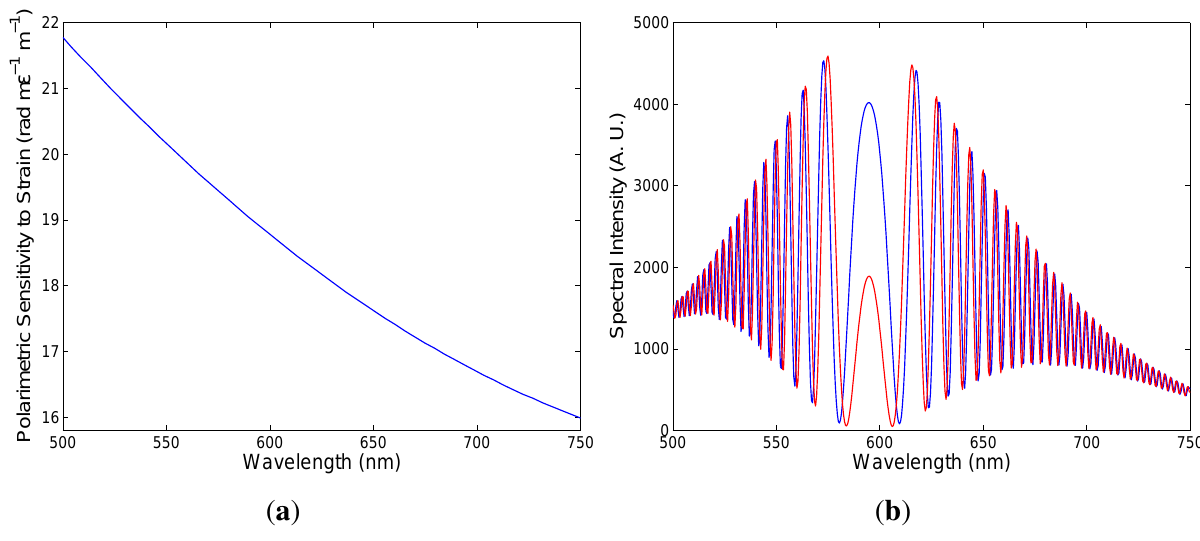
Figure 6. The spectral dependence of the polarimetric sensitivity to strain: a positive sign ( a ). Two theoretical spectra corresponding to the fiber elongations, ∆ L = 100 (cid:22) m (blue) and ∆ L = 150 (cid:22) m (red) ( b